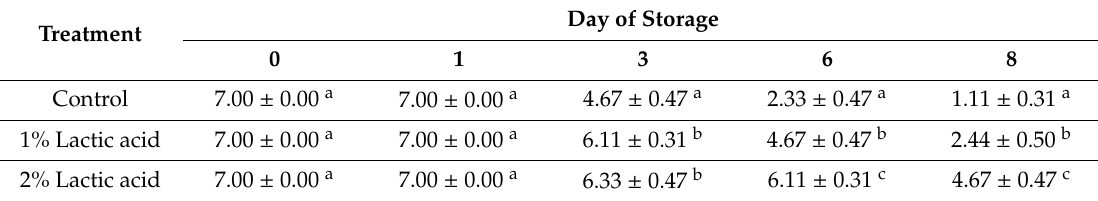
Table 2. Overall appearance of chicken legs treated with lactic acid and stored at 4 ◦ C.